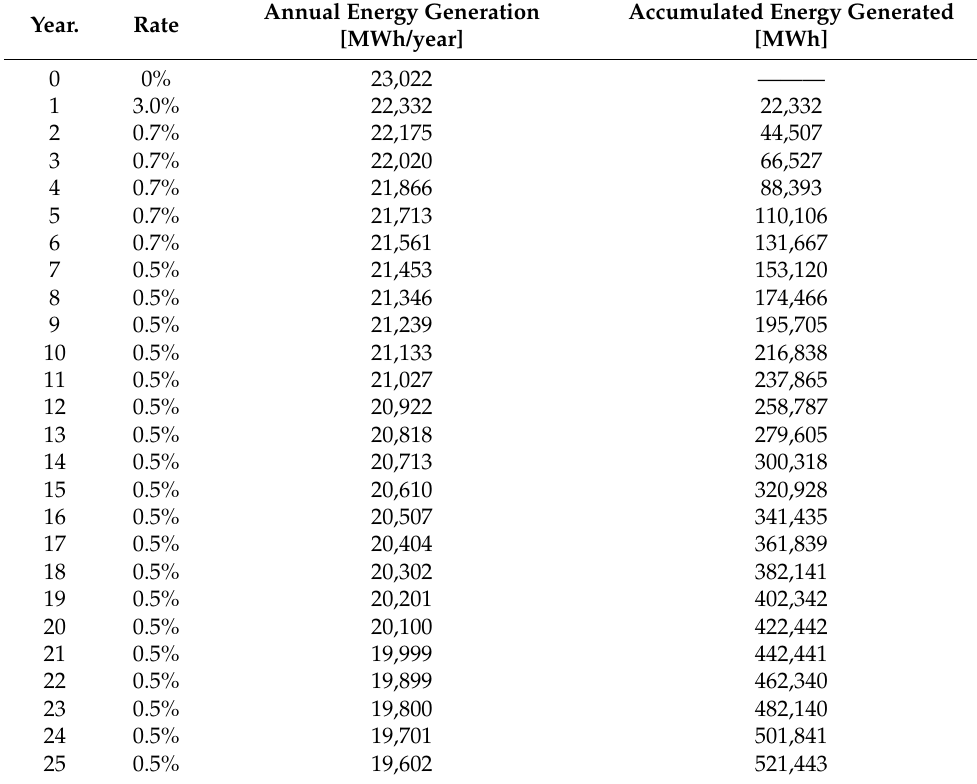
Table A3. Annual and accumulated energy generation, considering